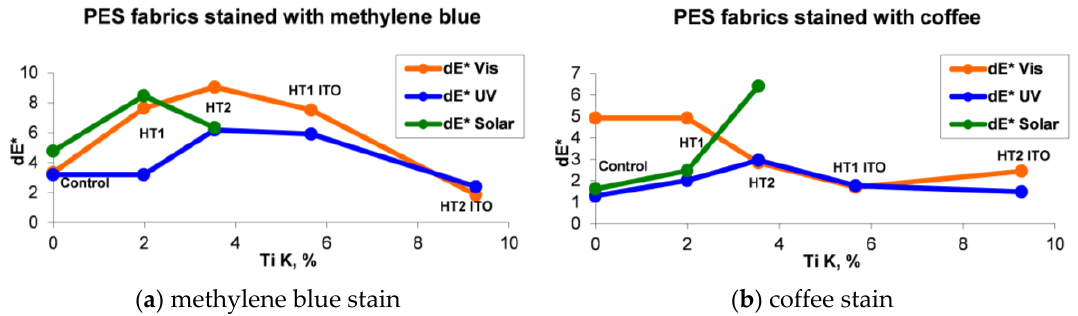
Figure 4. Correlation between percentage weights of Ti K and color differences ( dE* ) of the polyester fabrics treated with TiO 2 -1% Fe–N photocatalysts, stained with methylene blue ( a ) or coffee ( b ), and exposed to visible, ultraviolet (UV), and solar light.